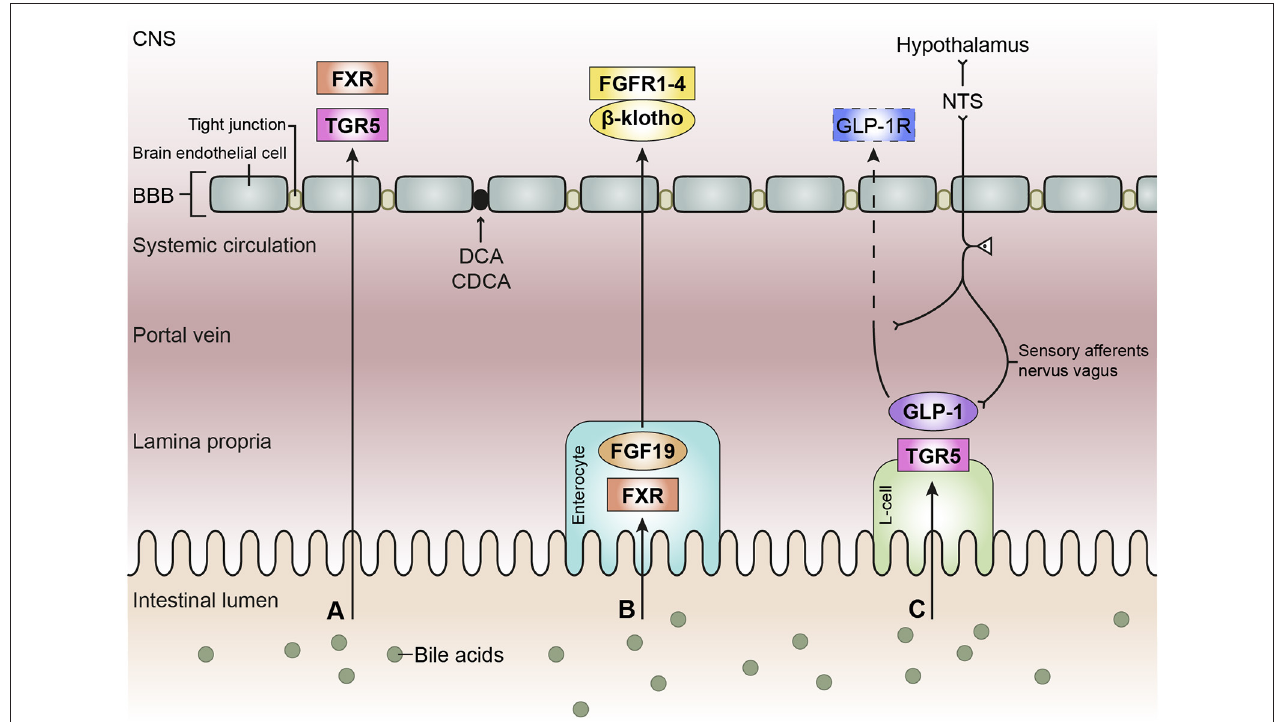
FIGURE 3 | Schematic overview of the bile acid signaling pathways to the central nervous system. Bile acids in the intestinal lumen can signal to the central nervous system (CNS) via different pathways, in this review we focused on the direct pathway (A) , the indirect pathway via farnesoid X receptor-fibroblast growth factor 19 (FXR-FGF19) signaling (B) , and the indirect pathway via Takeda G protein-coupled receptor-glucagon-like peptide-1 (TGR5-GLP-1) signaling (C) . (A) Bile acids in the intestine escape the enterohepatic circulation and reach the systemic circulation. Bile acids need to pass the blood-brain barrier (BBB) in order to interact with receptors in the brain, e.g., FXR and TGR5. Deoxycholic acid (DCA) and chenodeoxy cholic acid (CDCA) have been found to interact with gap junction proteins, resulting in a leaky BBB. (B) Bile acids taken up by enterocytes can activate the nuclear receptor FXR, which results in the release of FGF19. FGF19 is released by the enterocyte and reaches the portal vein, a small portion of FGF19 will not be taken up by the liver and enters the systemic circulation. FGF19 needs to cross the BBB to interact with FGF receptors (1–4) in the brain. The protein β -klotho is necessary for the formation of a stable receptor-complex. (C) in the intestine, a specific group of enteroendocrine cells, L-cells, produces GLP-1 upon the activation of TGR5 which can be triggered by bile acids. GLP-1 is quickly degraded by the enzyme dipeptidyl peptidase-4 (DPP-4, not shown), consequently high concentrations of GLP-1 are only found in the lamina propria of the intestine. A small portion of intact GLP-1 reaches the portal vein and even a smaller portion reaches the systemic circulation. It is questionable whether sufficient intact GLP-1 reaches the brain to interact with GLP-1 receptors, hence the dashed line. GLP-1 receptors are also expressed on afferent terminals of the vagal nerve present in the lamina propria and portal vein. The vagal nerve projects to the nucleus of the solitary tract (NTS) in the brainstem, from where projections are directed toward other brain regions, e.g. the hypothalamus (the vagal-brainstem-hypothalamic